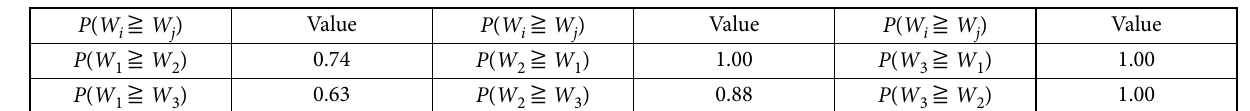
Table 9. The result of P ( W i ≥ W j )